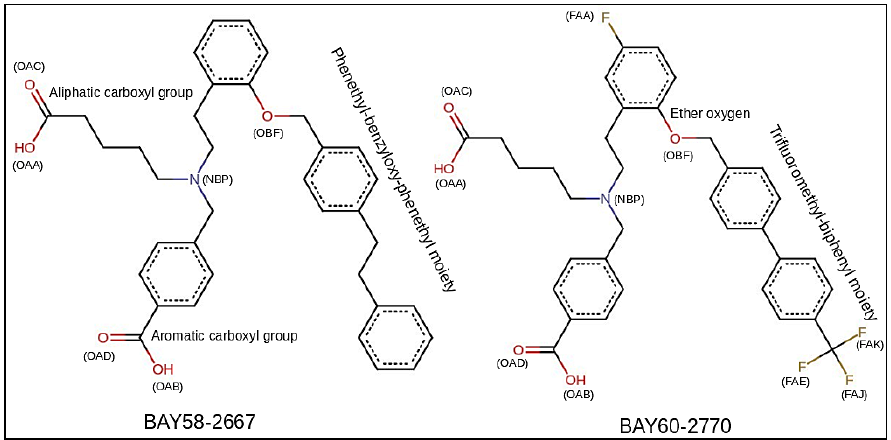
Figure 1. BAY activators, BAY58-2667 (4-[[(4-carboxybutyl)[2-[2-[[4-(2-phenylethyl)phenyl]methoxy] phenyl] ethyl]amino]methyl]benzoic acid) and BAY60-2770(4-({(4-carboxybutyl)[2-(5-fluoro-2-{[4’- (trifluoromethyl)biphenyl-4-yl]methoxy}phenyl)ethyl]amino}methyl)benzoic acid) used in this study; conventional names and chemical structure of both the activators are also given. Aliphatic and aromatic carboxyl groups are illustrated as OAC, OAA, and OAD, OAB respectively; Fluorine atoms of BAY60-2770’s fluoro and trifluoromethyl-biphenyl moieties have been represented as FAA, FAE, FAJ, and FAK.